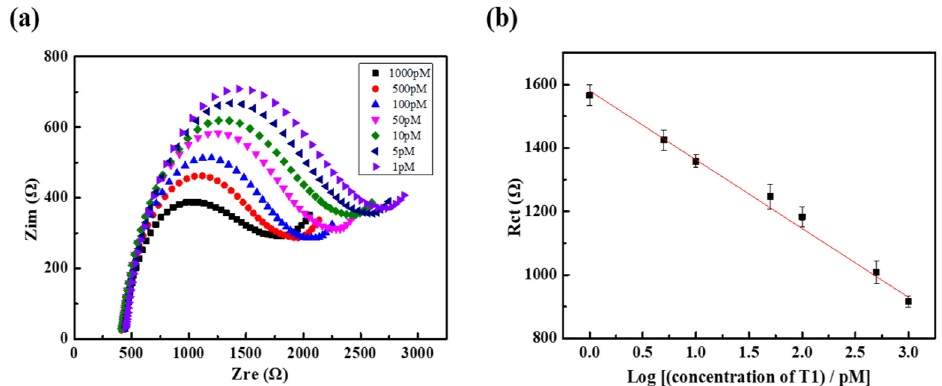
Figure 8. ( a ) Nyquist plots for the 1 nM probe DNA and various target (T1) concentrations and ( b ) plot of R ct values against the logarithm of the various target (T1) concentrations.